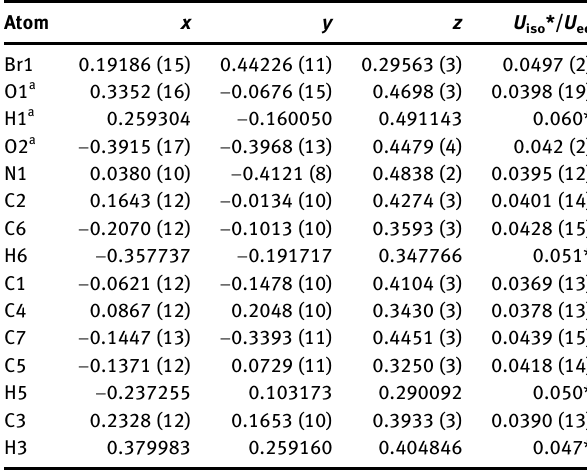
Table  : Fractional atomic coordinates and isotropic or equivalent isotropic displacement parameters (Å 